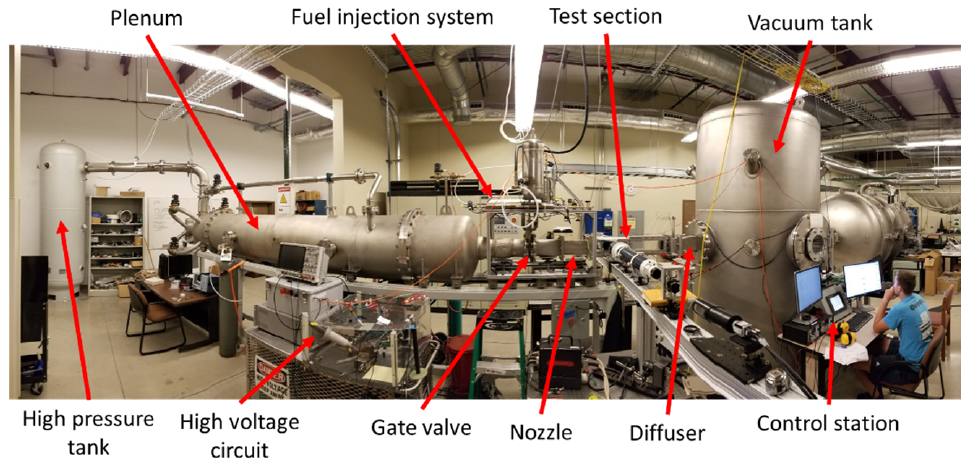
Figure 1. Overall view of the SBR-50 facility with major components